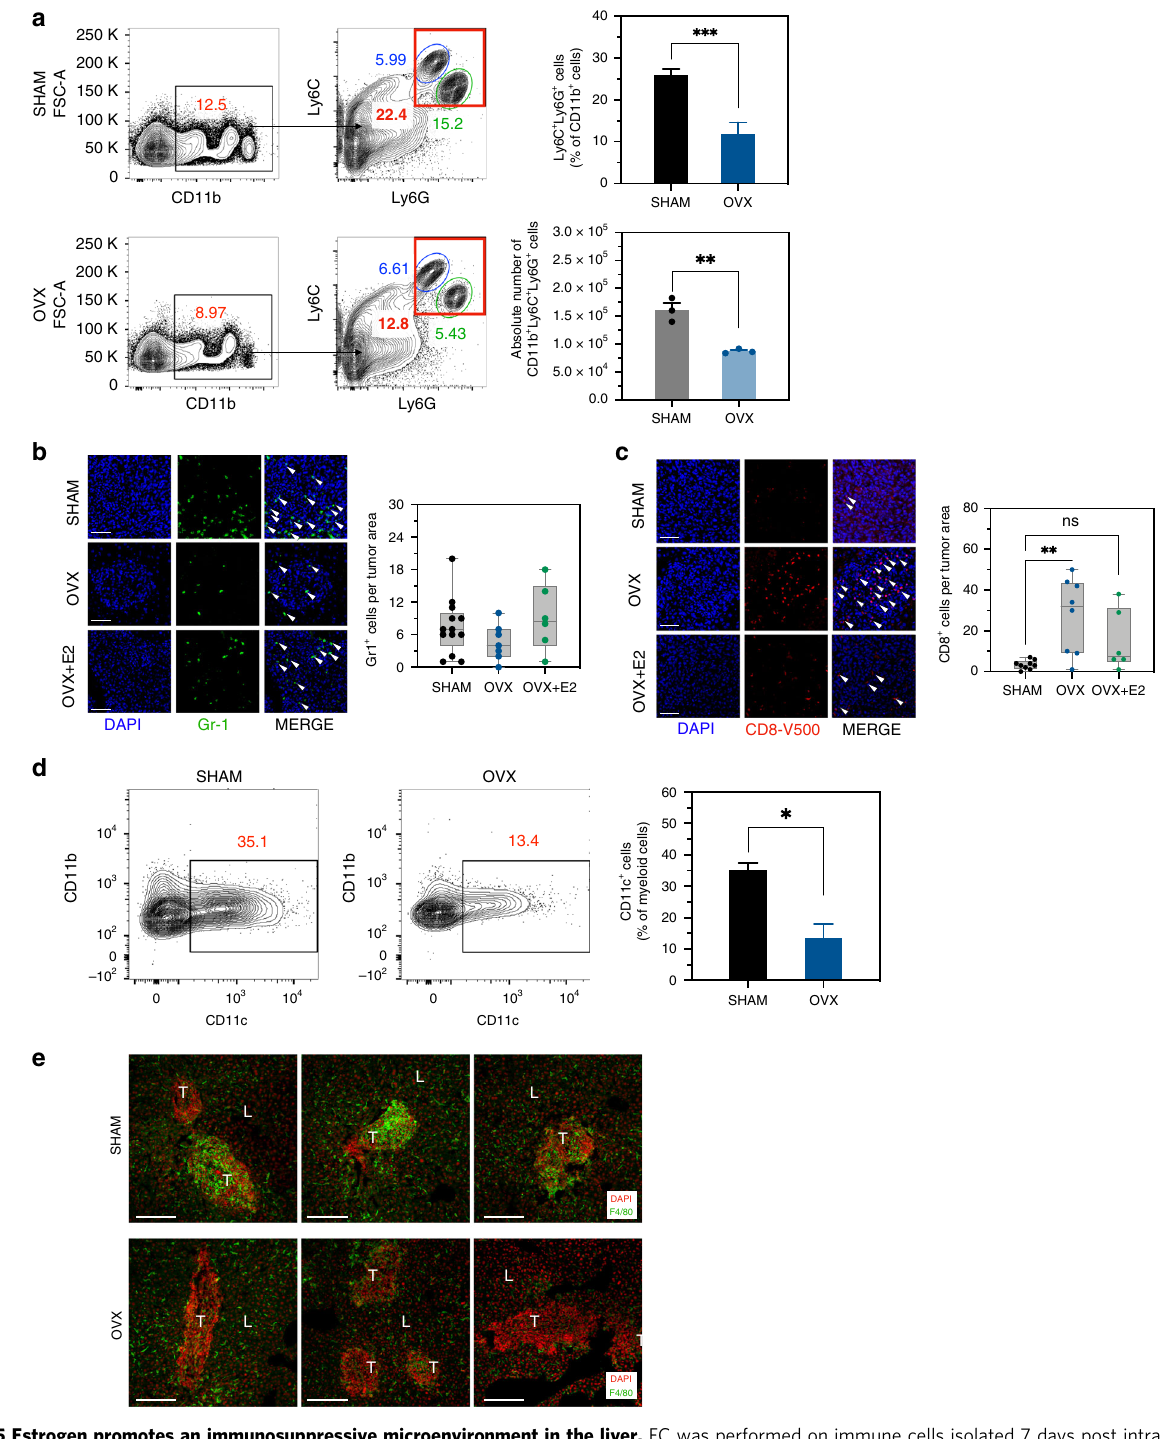
Fig. 5 Estrogen promotes an immunosuppressive microenvironment in the liver. FC was performed on immune cells isolated 7 days post intrasplenic/ portal injection of 5 × 10 5 MC-38 cells and immunostained with the indicated antibodies. Shown in a (left) are the contour plots obtained for each group and in a (right) the proportion (%) of CD11b + Ly6C + Ly6G + cells per total liver immune cells expressed as means (±s.d.) of three experiments, each performed on a pool of fi ve livers per group. Shown in b , c and e are representative confocal images from 10 μ m cryostat liver sections obtained 7 days post intrasplenic/portal inoculation of 5 × 10 5 MC-38 cells and immunostained with the indicated antibodies followed by Alexa Fluor 568 (green) for Gr-1 ( b ), Alexa Fluor 647 (red) for CD8 ( d ), Alexa Fluor 647 (green) for F4/80 ( e ), and 4 ′ ,6-diamidino-2-phenylindole (DAPI; blue in b and c , and red in e ). Shown on the right of the confocal images are the numbers (means ± s.e.m.) of the indicated cells per fi eld counted in 7 fi elds (OVX, OVX + E2) or 12 fi elds (sham) per group. Shown in d (left) are representative fl ow cytometric contour plots obtained for the indicated groups and in d (right) the mean proportion of CD11b + CD11c + cells per liver based on a pool of fi ve livers per group, analyzed in triplicates. * − p ≤ 0.05; ** − p ≤ 0.01; *** − p ≤ 0.001; NS, not signi fi cant as determined by the Student's t -test. Box and whiskers graphs: the box extends from the 25th to 75th percentiles, the middle line denotes the median and the whiskers extends from the minimum to the maximum value. Scale bars correspond to 100 µ m on IF